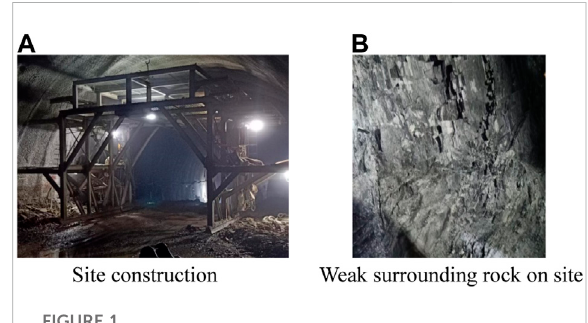
FIGURE 1 Tunnel site conditions. (A) Site construction; (B) weak surrounding rock on the